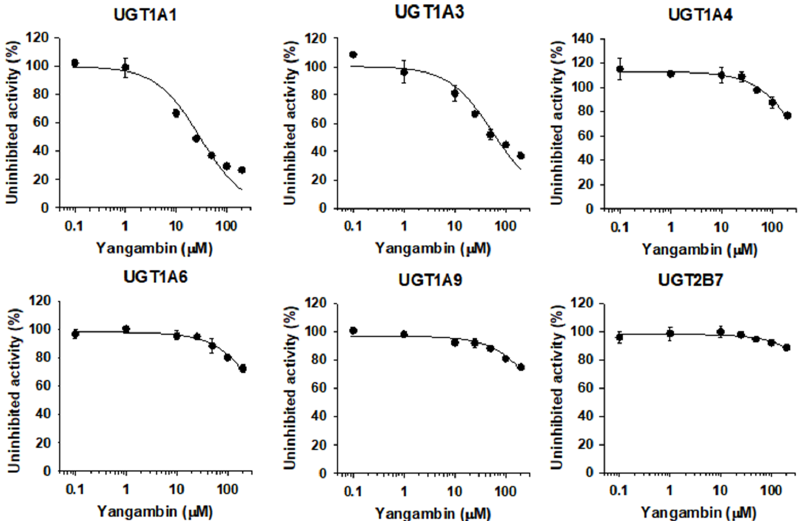
Table 2. Kinetic parameters for the inhibition of eudesmin, fargesin, epimagnolin A, magnolin, and yangambin on UGT1A1 and UGT1A3 enzyme activities in pooled human liver microsomes. Figure 6. Inhibitory effects of yangambin (0.1–200 µ M) on UGT1A1-, UGT1A3-, UGT1A4-, UGT1A6-, UGT1A9-, and UGT2B7-mediated glucuronidation of 0.5 µ M SN-38, 2 µ M chenodeoxycholic acid, 0.5 µ M trifluoperazine, 1 µ M N -acetylserotonin, 0.2 µ M mycophenolic acid, and 1 µ M naloxone, a probe substrate for UGT1A1, UGT1A3, UGT1A4, UGT1A6, UGT1A9, and UGT2B7, respectively, in human liver microsomes. The data are expressed as means ± standard deviations ( n = 3).